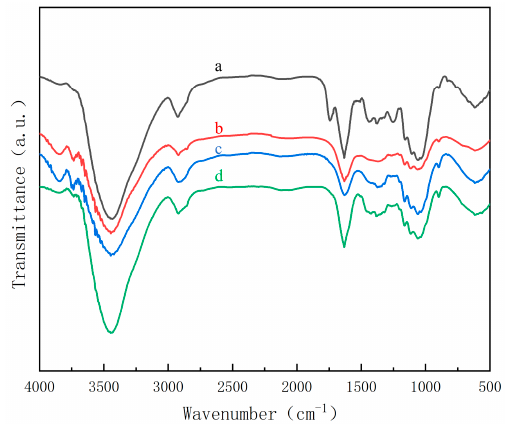
Figure 1. FTIR spectra ((a) Washed durian rind powder; (b) Sample treated with sodium carbonate; (c) Sample treated with sodium chlorite; (d) Sonicated sample).